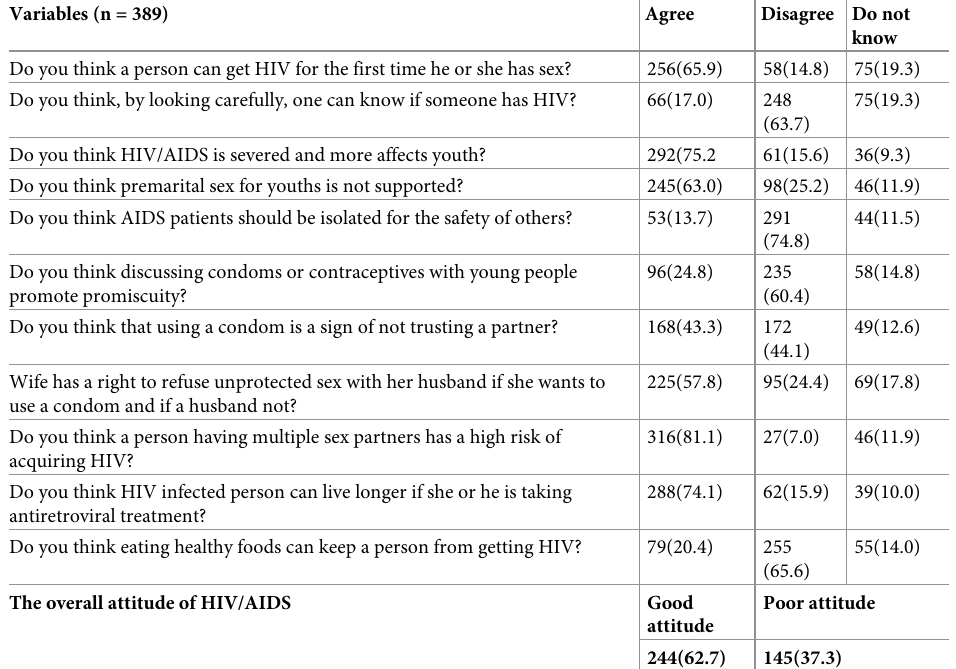
Table 4. The respondents’ attitude towards HIV/AIDS in North-shewa zone, Ethiopia, 2019. Variables (n = 389) Agree Disagree Do not Do you think a person can get HIV for the first time he or she has sex? 256(65.9) 58(14.8) 75(19.3) Do you think, by looking carefully, one can know if someone has HIV? 66(17.0) 248 Do you think HIV/AIDS is severed and more affects youth? 292(75.2 61(15.6) 36(9.3) Do you think premarital sex for youths is not supported? 245(63.0) 98(25.2) 46(11.9) Do you think AIDS patients should be isolated for the safety of others? 53(13.7) 291 Do you think discussing condoms or contraceptives with young people promote promiscuity? Do you think that using a condom is a sign of not trusting a partner? 168(43.3) 172 Wife has a right to refuse unprotected sex with her husband if she wants to use a condom and if a husband not? Do you think a person having multiple sex partners has a high risk of acquiring HIV? Do you think HIV infected person can live longer if she or he is taking antiretroviral treatment? Do you think eating healthy foods can keep a person from getting HIV? 79(20.4) 255 The overall attitude of HIV/AIDS Good